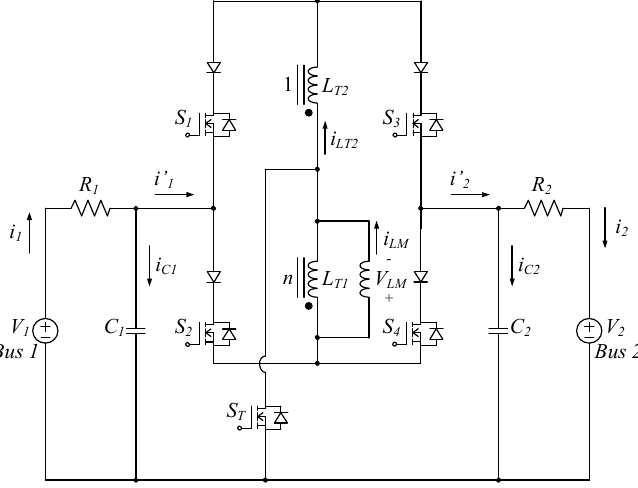
Figure 1. The 5-switch bi-directional DC-DC converter.